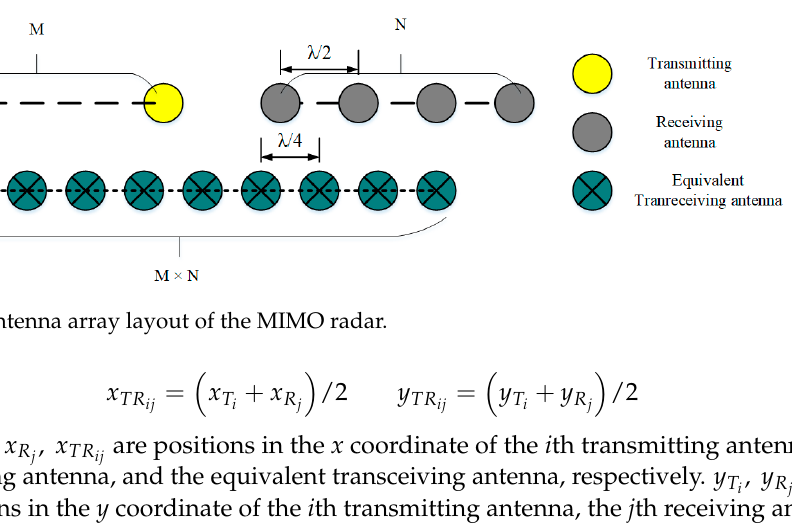
Figure 1. Multiple target deformation measurement with a MIMO interferometric radar.